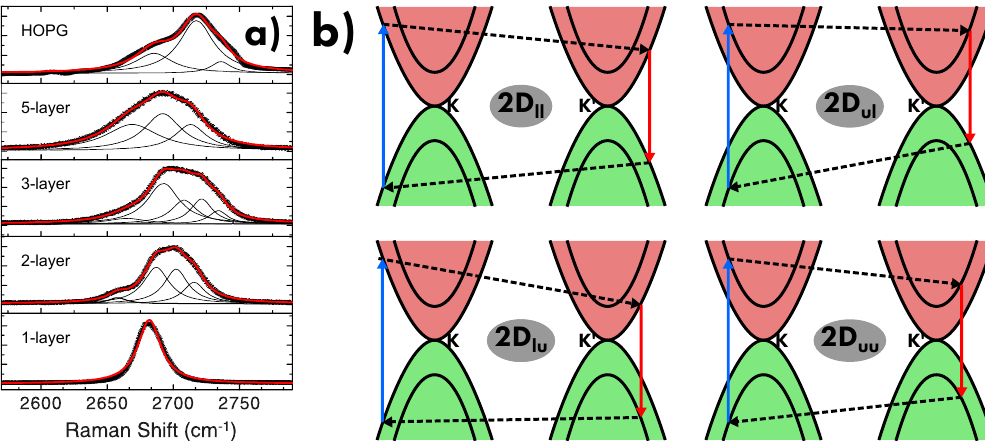
Figure 19. ( a ) Lorentzian component of 2D band for single-layer graphene, multi-layer graphene and HOPG characterized by various numbers of layer. Reprinted with permission from Ref. [70]. Copyright (2010) American Institute of Physics. ( b ) Splitting of conduction and valence band of two-layer graphene where four 2D scattering processes are possible. Adapted with permission from Ref. [42]. Copyright (2013)